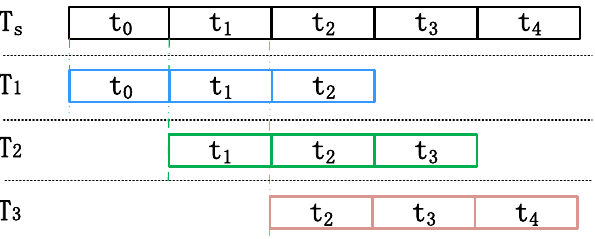
Figure 9. Coal volume time series calculation.